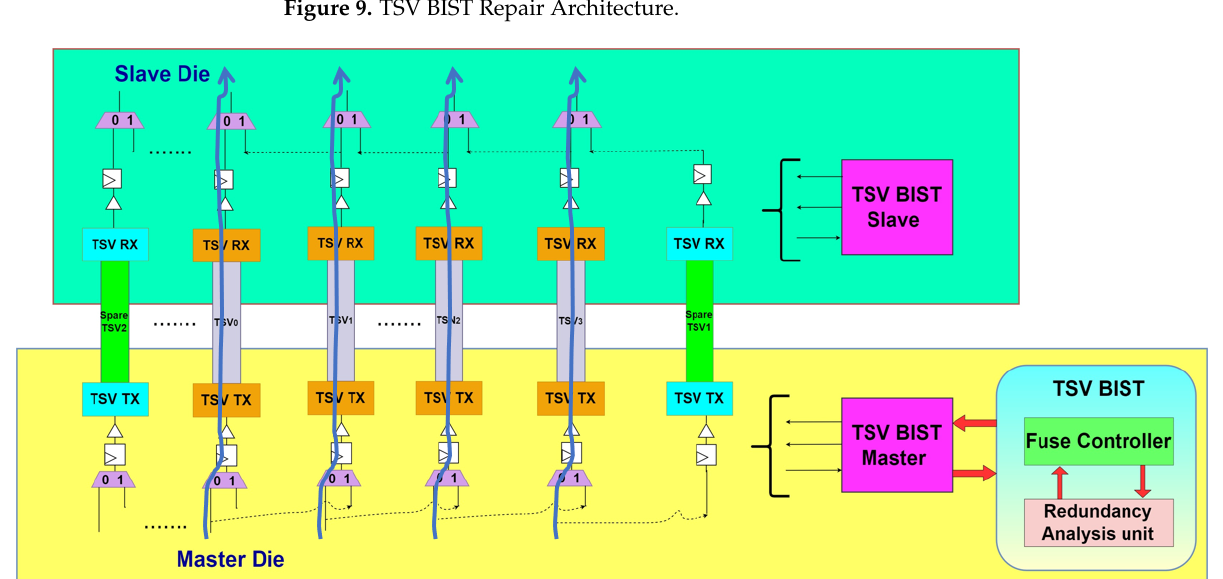
Figure 9. TSV BIST Repair Architecture.